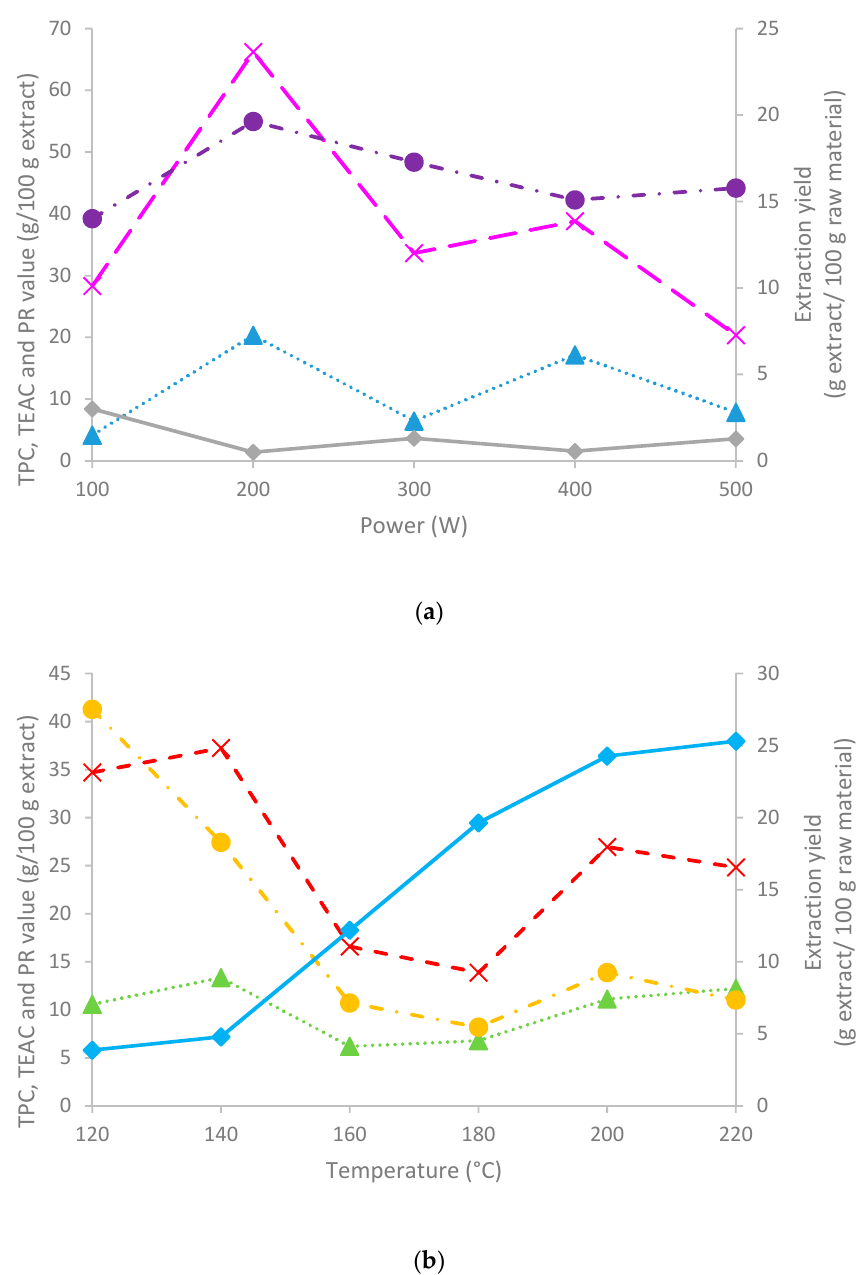
Figure 3. Influence of ( a ) the operation power during UAE on the microwave hydrodiffusion gravity-UAE stage, and the ( b ) the final heating temperature during autohydrolysis on the extraction yield (as g extract/100 g), total phenolics content (TPC), and TEAC value and reducing power (PR) of the extracts. Symbols: triangles (TPC), circle (PR), diamond (extraction yield), crosses (TEAC value). Data represent n ≥ 3; SD < 5%. Note here that the continuous lines correspond to the secondary axis.